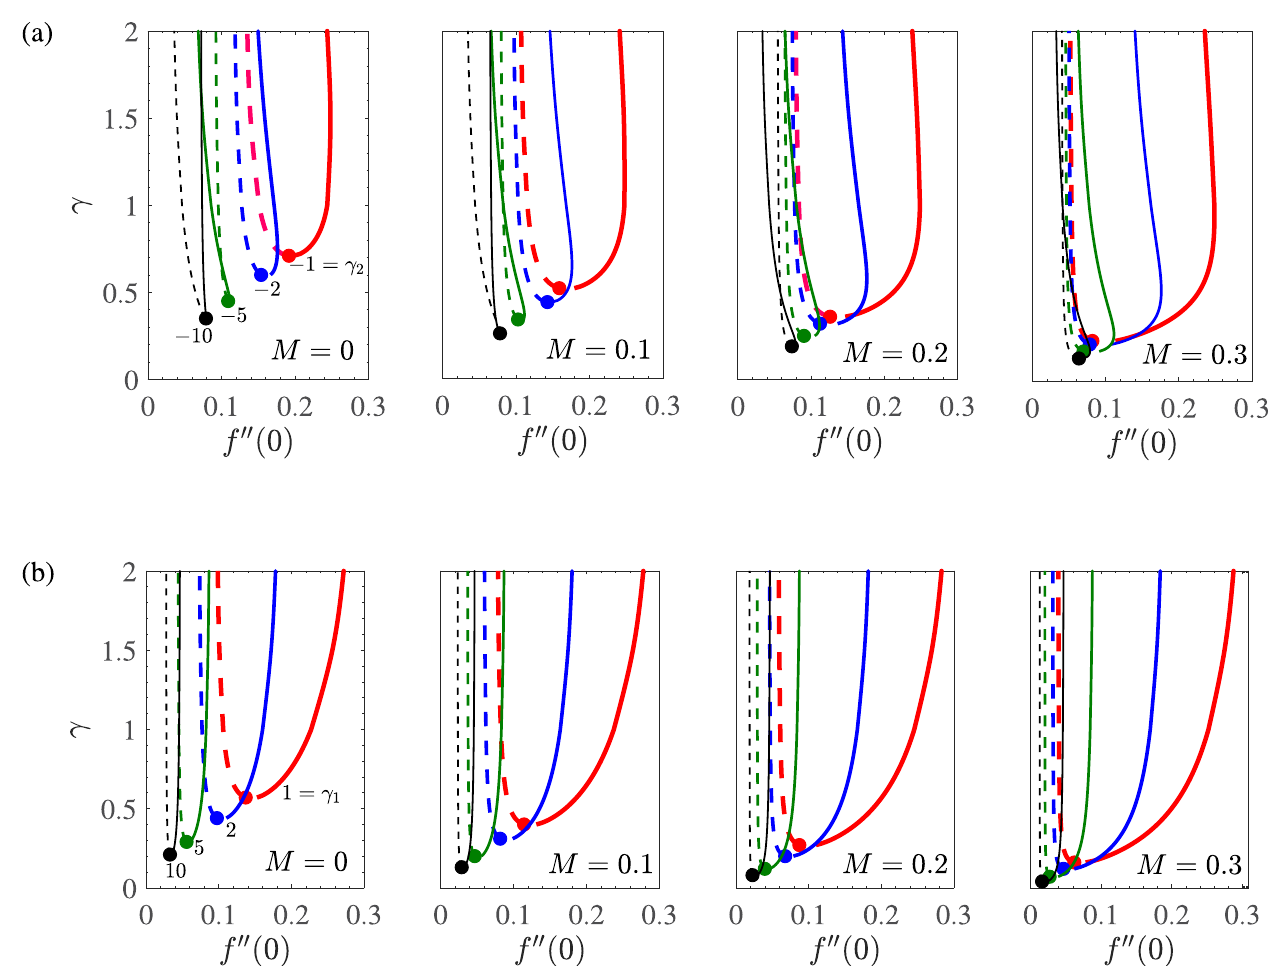
Fig 7. γ vs f 00 (0) for V c = 2 and m 1 = − 0.5 for the shrinking sheet case with mass suction. All the cases considered here correspond to the dual solutions. The pair of (one dashed and one solid curve) solutions in each case is separated by the bifurcation point •.